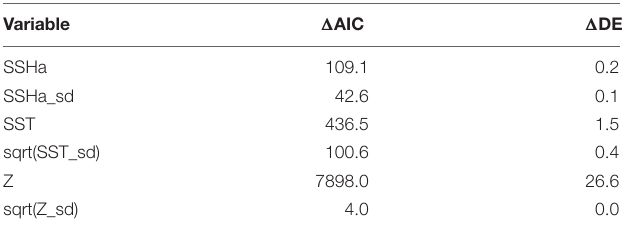
TABLE 5 | Variable importance for the GAMM of habitat suitability was assessed by comparing the difference in AIC ( (cid:49) AIC) and the difference in percent deviance explained ( (cid:49) DE) following variable removal from the model. Larger values indicate greater variable